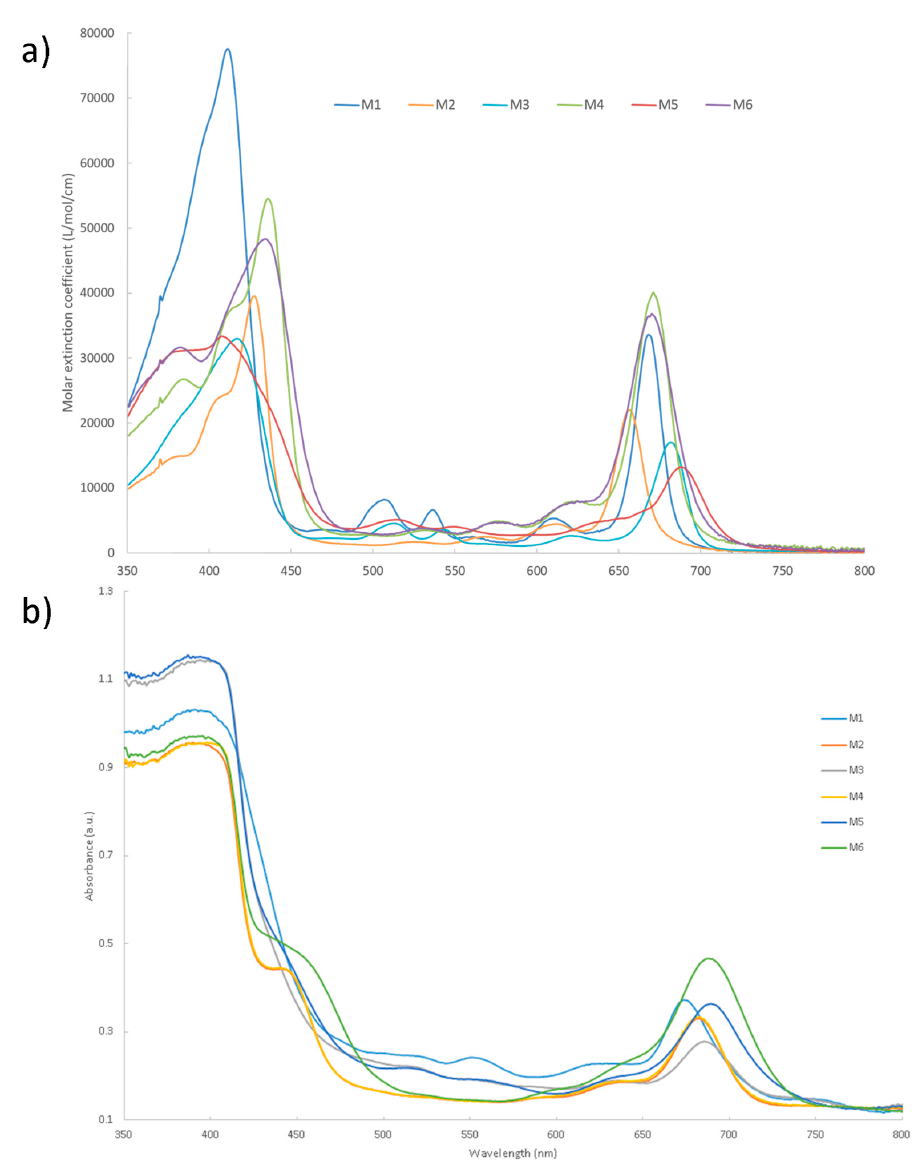
Figure 1. ( a ) UV-Visible absorption spectra of chlorins M1 – M6 in THF and ( b ) grafted onto the TiO 2 surface.